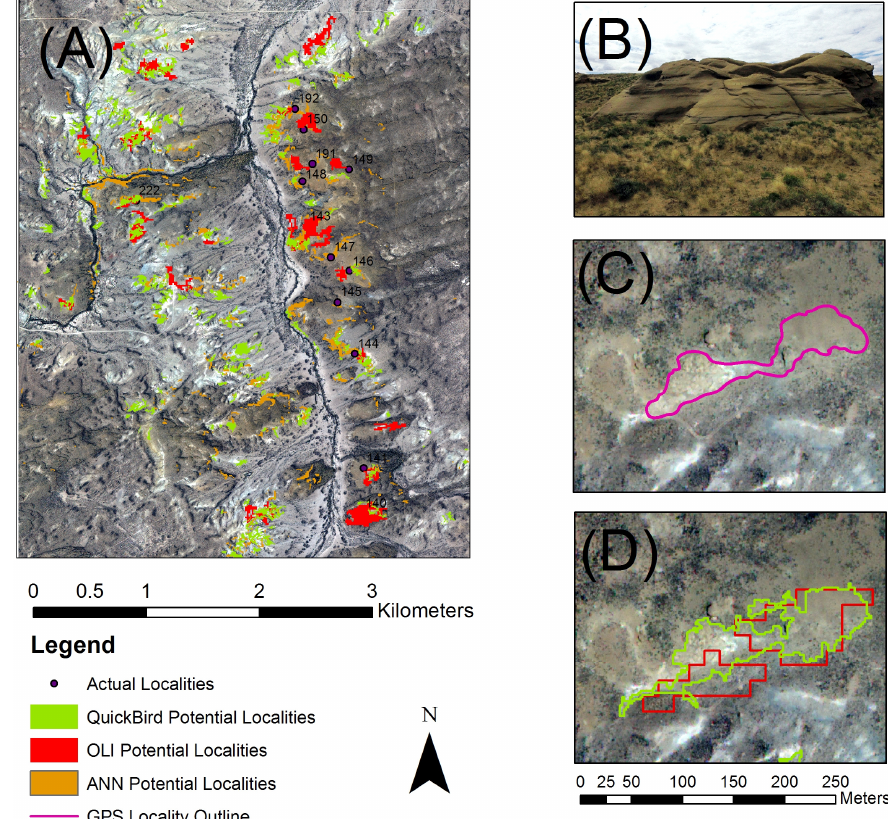
Figure 2. QuickBird image of the training area ( A ) showing ANN-, OLI-, and QuickBird-based model results and productive localities discovered in previous field seasons. ( B ) Ground level view of a sandstone outcrop at an example locality. The outer edge of the whole locality measured with a GPS ( C ). ( D ) The highlighted image objects for the QuickBird model (green) and the Landsat 8 OLI model (red). Because these localities are on public land and are therefore subject to possible illegal looting, the exact coordinates cannot be publicized under the terms of our collection permit.